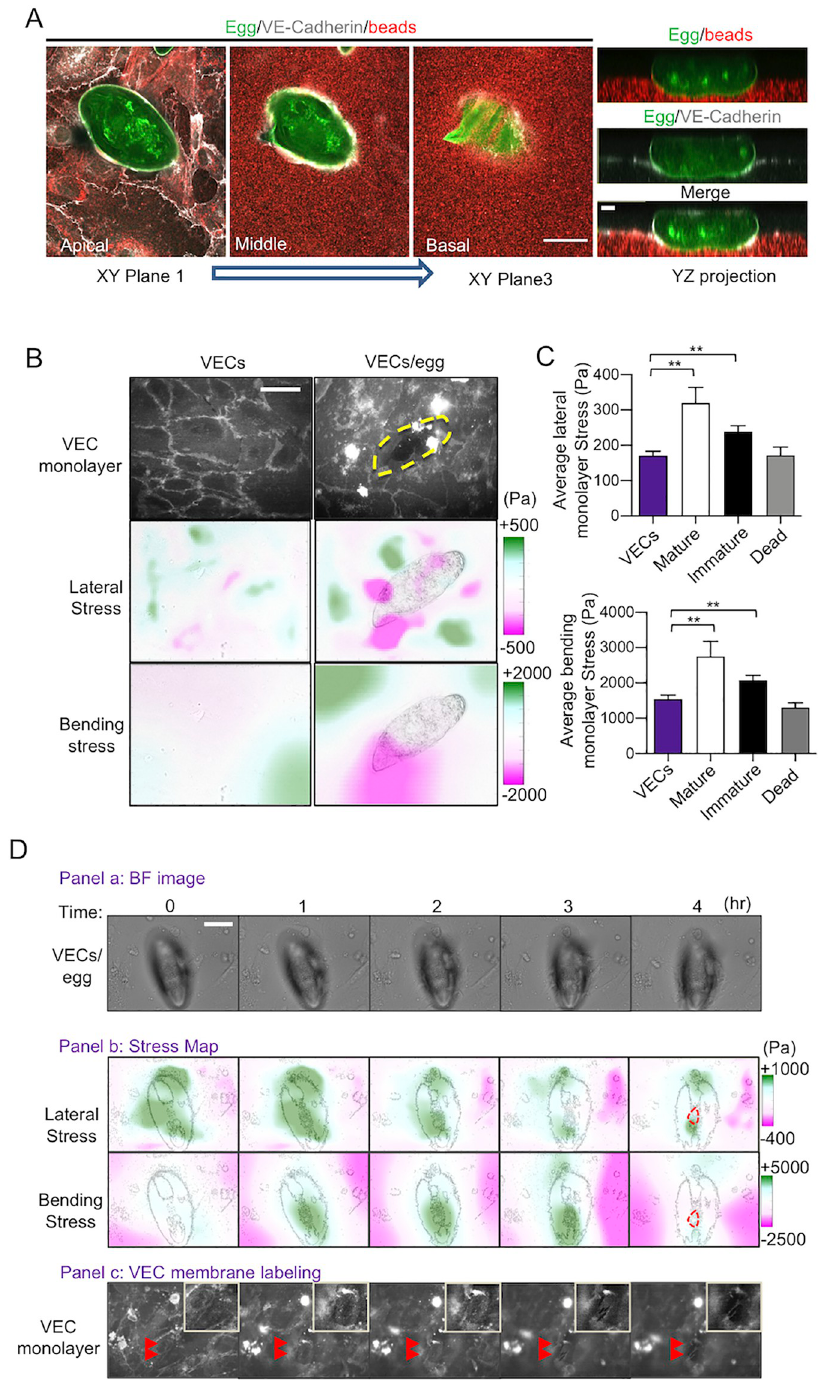
Fig 6. Increased monolayer tension during the encapsulation of S . mansoni ruptures VEC junctions. (A) Confocal images of a live mature egg being encapsulated by VECs after 4 h on a PA gel seeded with fluorescent beads. The three left-hand-side panels show xy images of VE-Cadherin staining (white), the egg (green) and beads within the gel (red), taken at the monolayer z-plane and then with increasing depth into the substrate (scale bar: 50 μ m). The right-hand- side panel shows the corresponding yz projection (scale bar: 10 μ m). (B) 3D stress patterns exerted by VEC monolayers in the presence and absence of a live mature egg after 4 h. The top row shows VEC junctions (scale bar: 50 μ m). The yellow dash line outlines the egg location. The second and third rows represent lateral and bending monolayer tensions, respectively. (C) Quantification of the lateral (upper graph) and bending (lower graph) monolayer